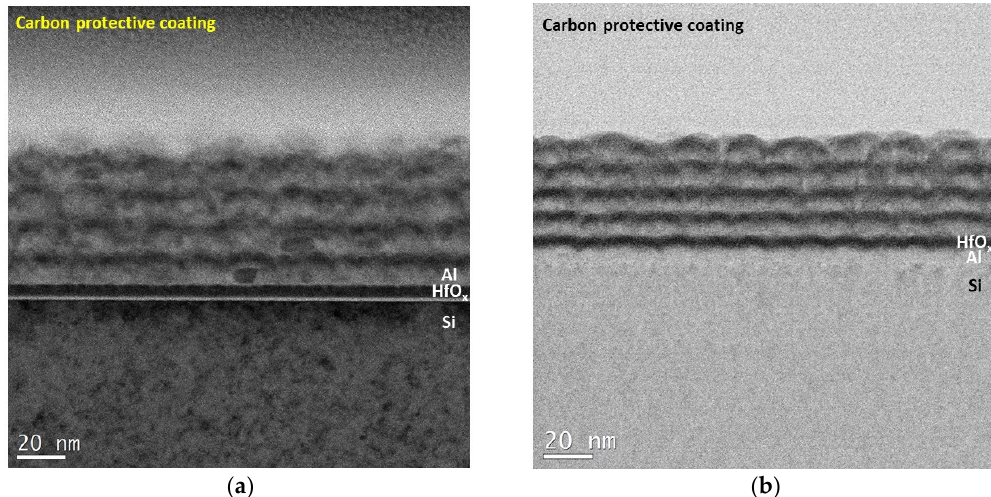
Figure 6. Comparison of HR-TEM cross-sections of structure based on alternative (5x) Al and HfO x layers fabricated by pulsed-DC magnetron sputtering processes; Al film was sputtered through the ( a ) ‘non-optimal’, and ( b ) ‘optimal’ recipe; the thickness of each film was set at ~5 nm.